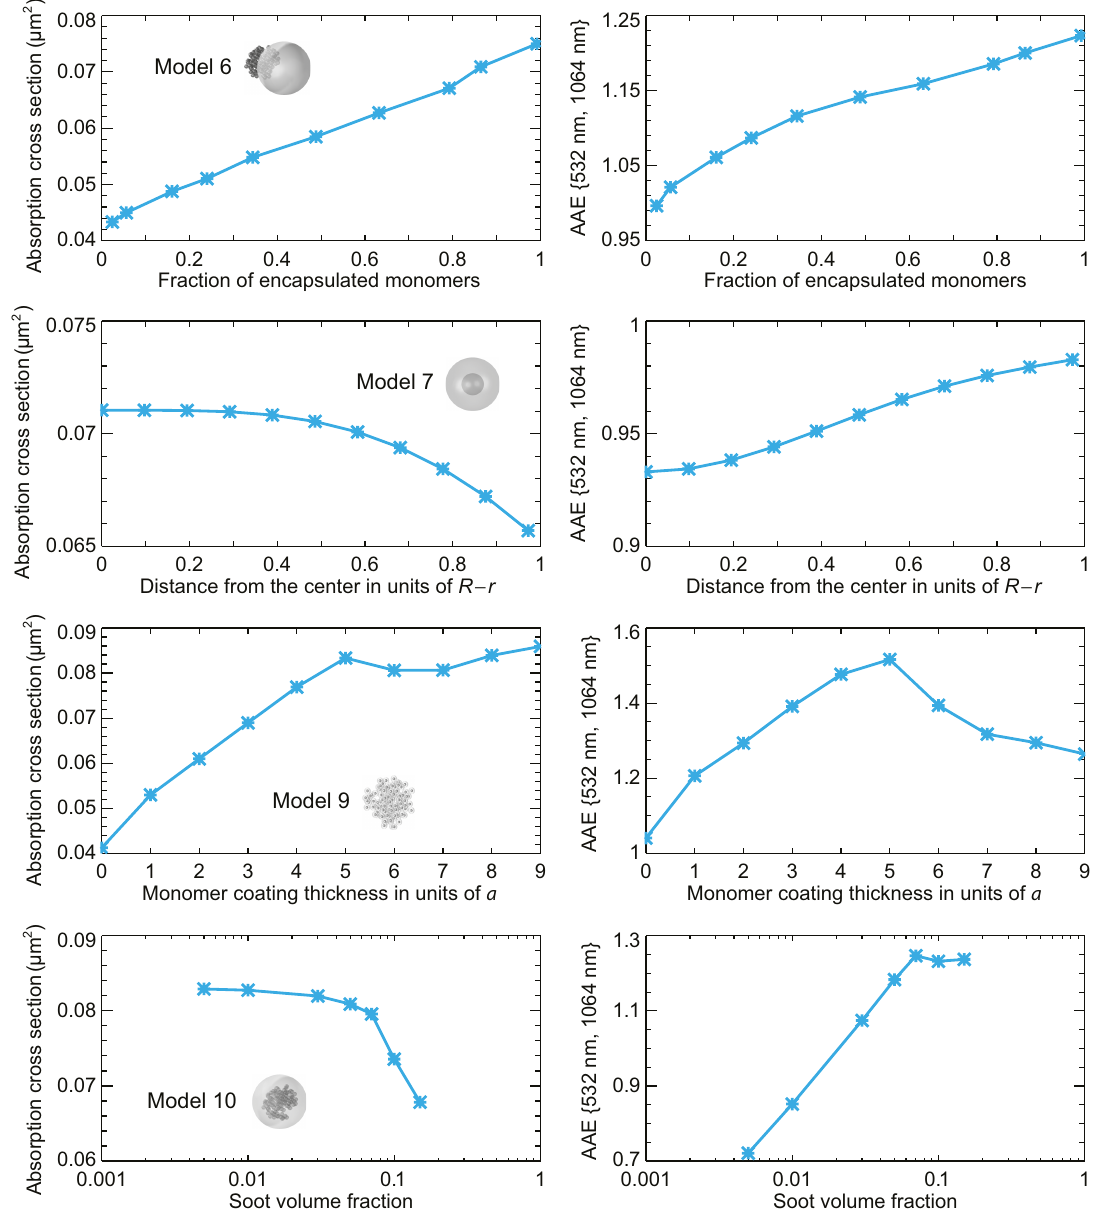
Figure 2. The absorption cross section at λ = 532 nm (left-hand panels) and the absorption Ångström exponent (AAE) computed for the {532 nm, 1064 nm} pair of wavelengths (right-hand panels) as functions of different microphysical parameters for monodisperse Model 6, 7, 9, and 10 particles.